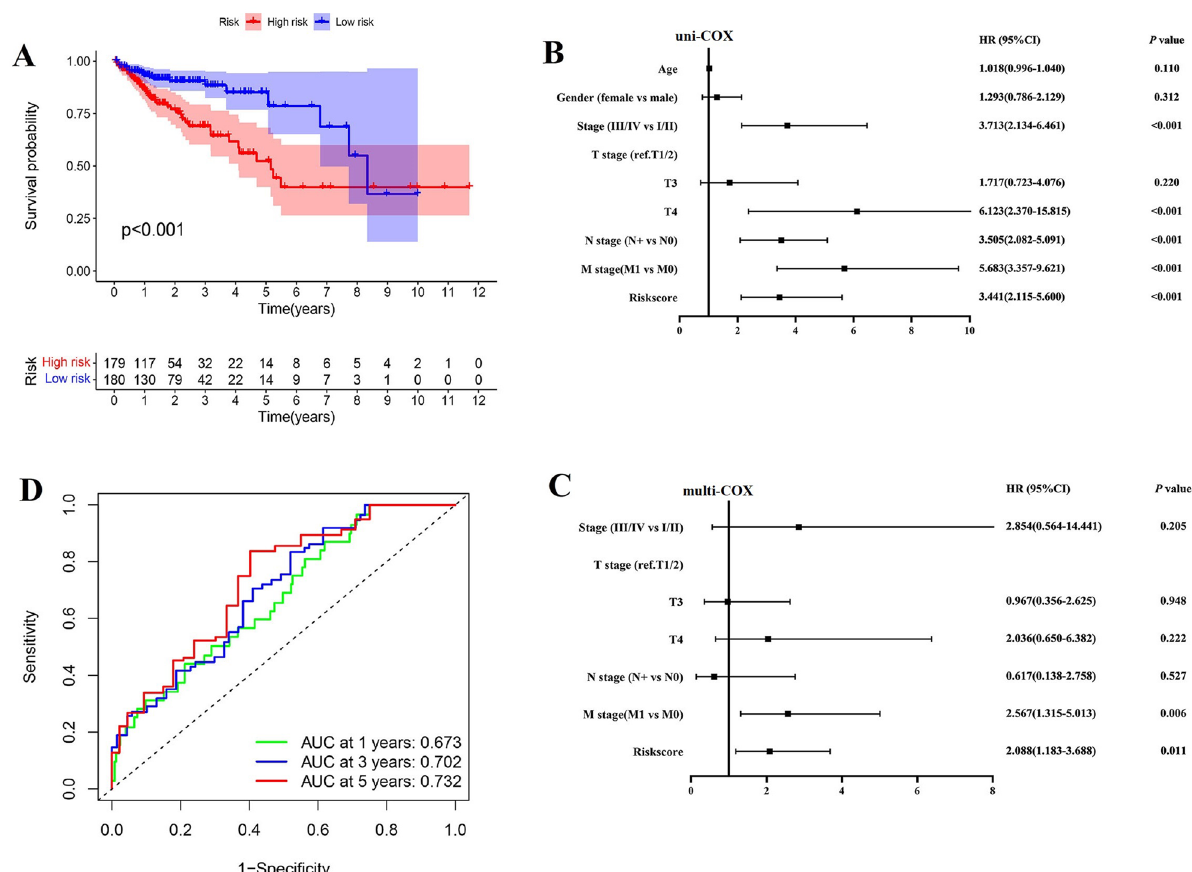
Figure 6. Difference in prognosis and signaling pathways between two subgroups and functional analysis. ( A ) Survival difference between low- and high- risk groups in TCGA training set. ( B ) and ( C ) Univariable and multivariable COX regression including clinicopathological traits and riskscore for OS. ( D ) ROC analysis to estimate the predictive efficiency of risk model. ( E ) KEGG functional analyses based on the risk model. ( F ) GSEA performed to show the difference in signaling pathway between subgroups. ( G ) clinical characteristics of